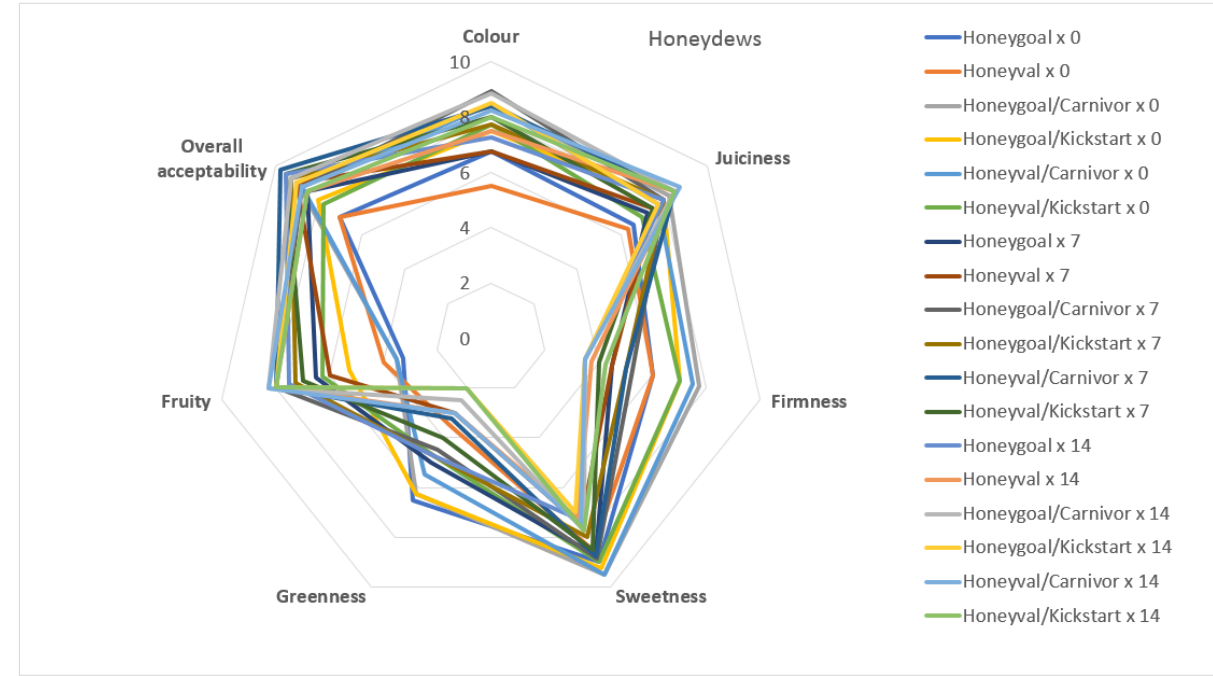
Figure 3. Sensory quality of grafted and un-grafted honeydew melons after cold storage.